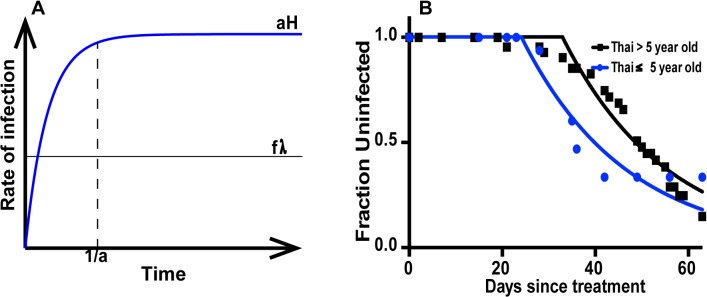
Dynamics of P. vivax infection with time.(A) Modeling the proportion of infections from new primary infection versus hypnozoite reactivation with time. In the presence of a constant rate of inoculation, the rate of primary infection (black line) will rapidly reach equilibrium and be constant with time. However, the rate of hypnozoite reactivation (blue line) will take some time to reach its steady state level. The time taken to reach this is dependent on the rate of reactivation of hypnozoites (a
H). (B) shows best-fits of time to Pv infection in children < 5 years or subjects >5 years old in the Thai study.